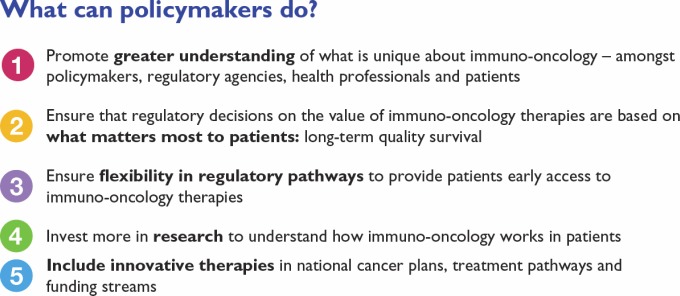
Key recommendations for policymakers on immuno-oncology [8].